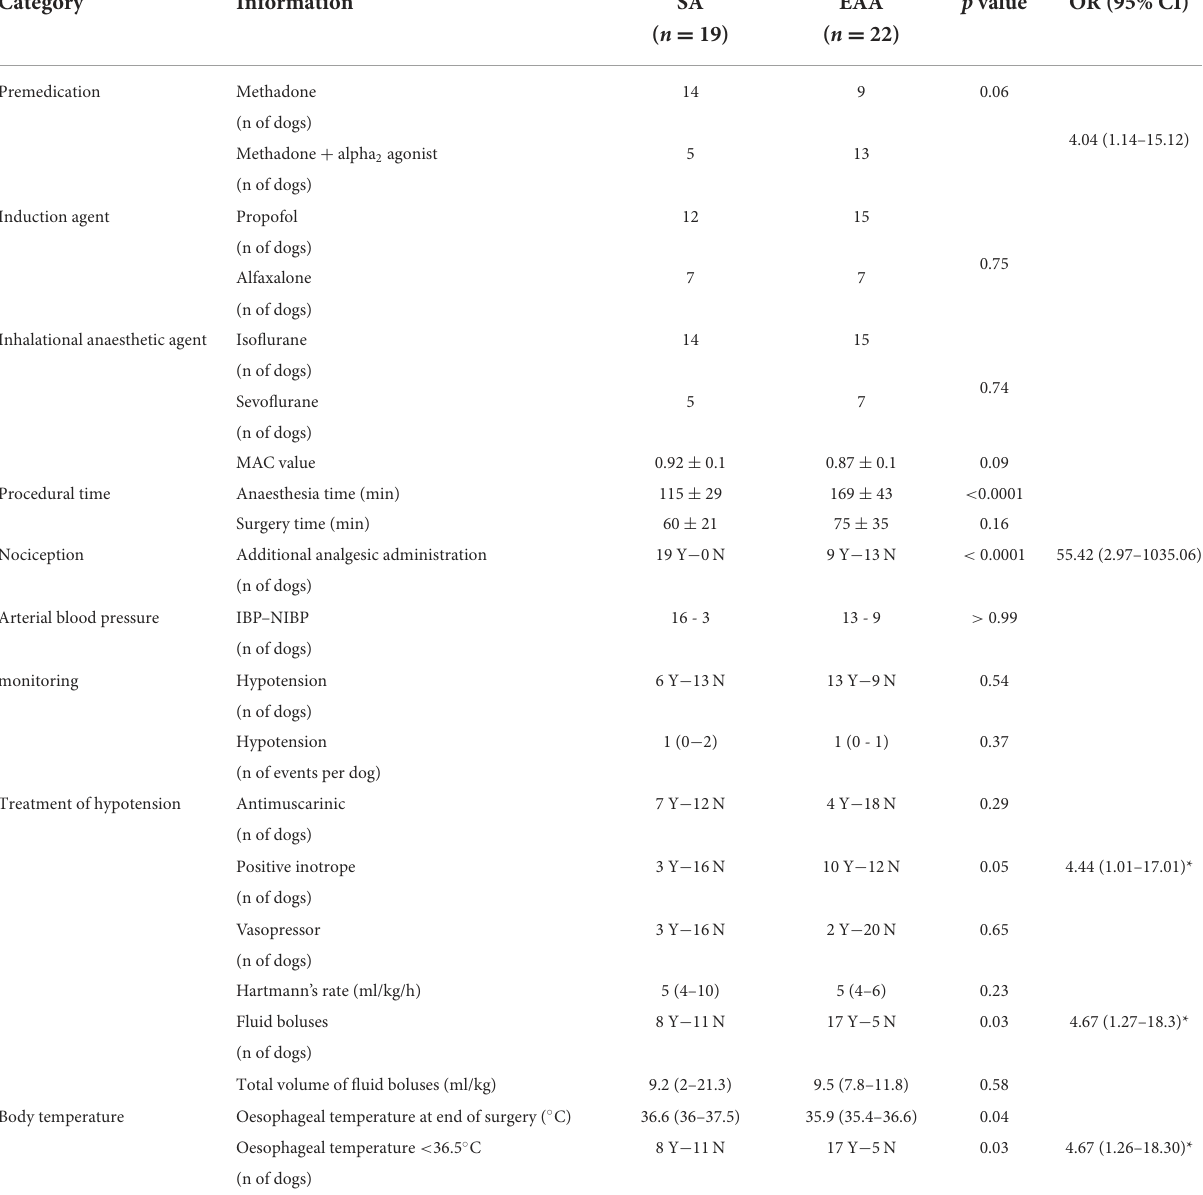
TABLE 2 Intraoperative information recorded from a cohort of dogs undergoing cholecystectomy and in which systemic analgesia (SA) or extradural anaesthesia-analgesia (EAA) were